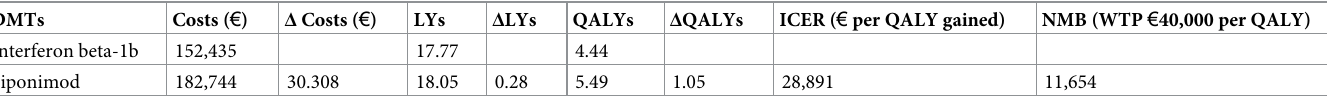
ICER: Incremental cost-effectiveness ratio; LY = life years; QALYs = Quality Adjusted Life Years; NMB = Net Monetary Benefit with a willingness to pay (WTP) of € 40,000 per QALY gained.